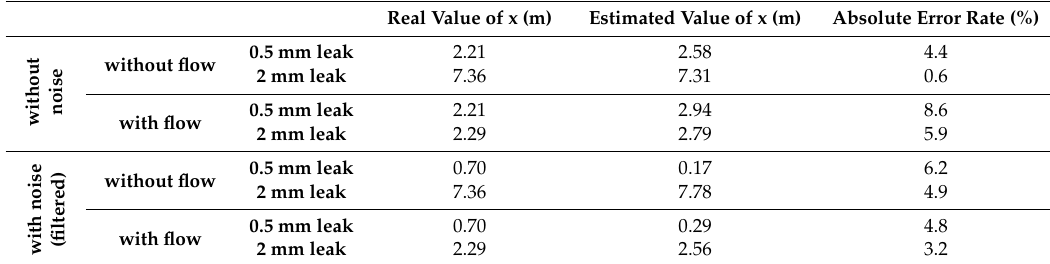
Table 2. Results from the CC method for 8.5 m distance between the sensors.